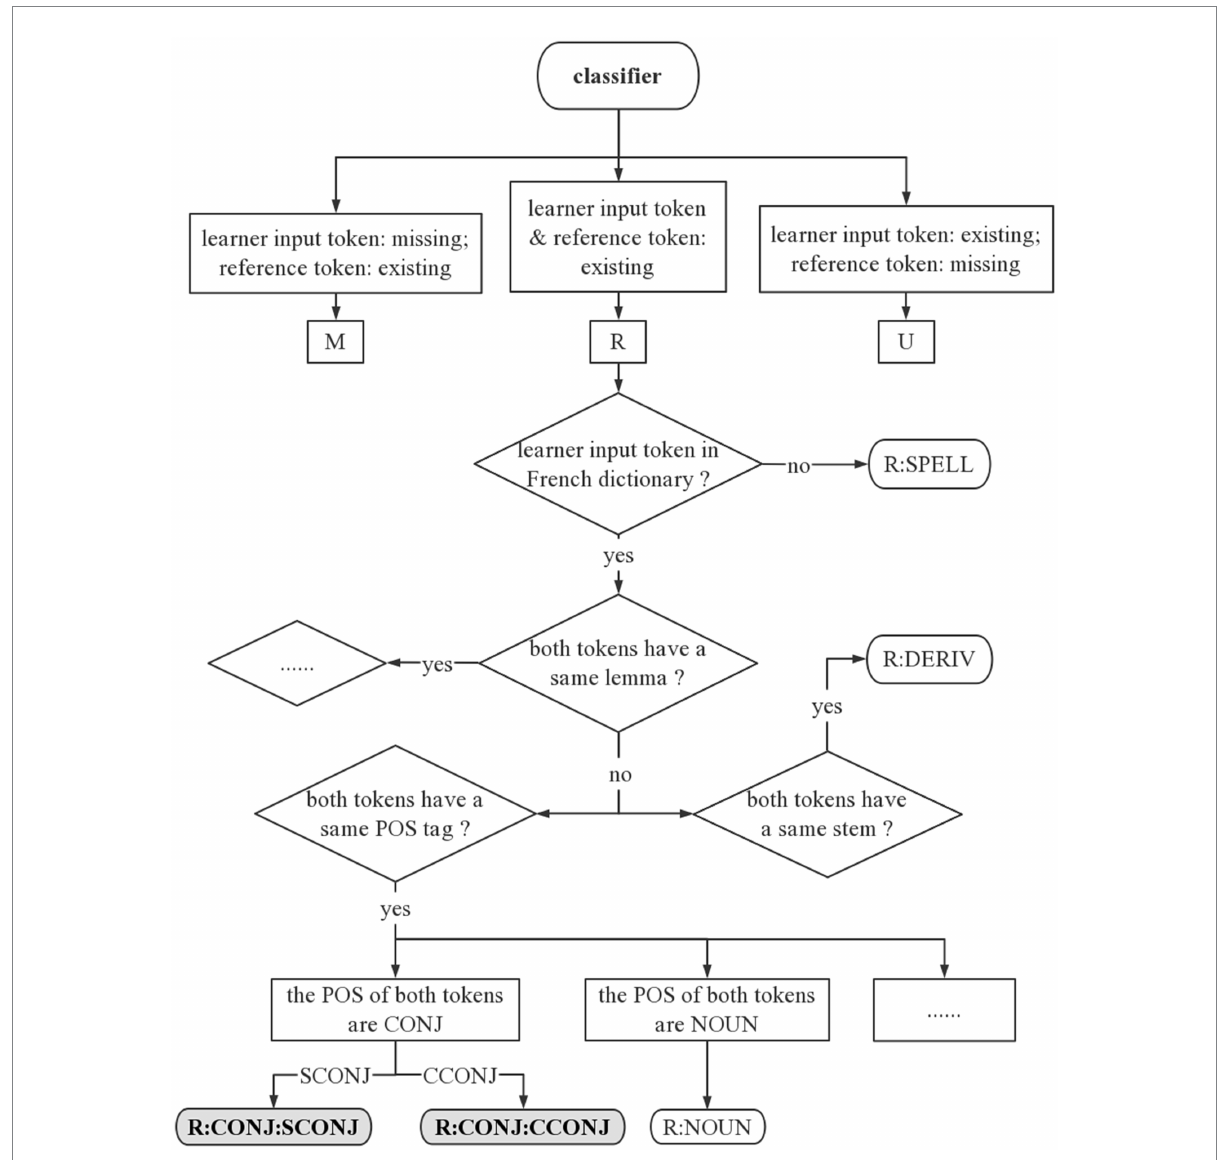
FIGURE 2 Examples of grammatical error classification. R:SPELL, R:DERIV, R:NOUN, R:CONJ:SCONJ, and R:CONJ:CCONJ are classified using logic